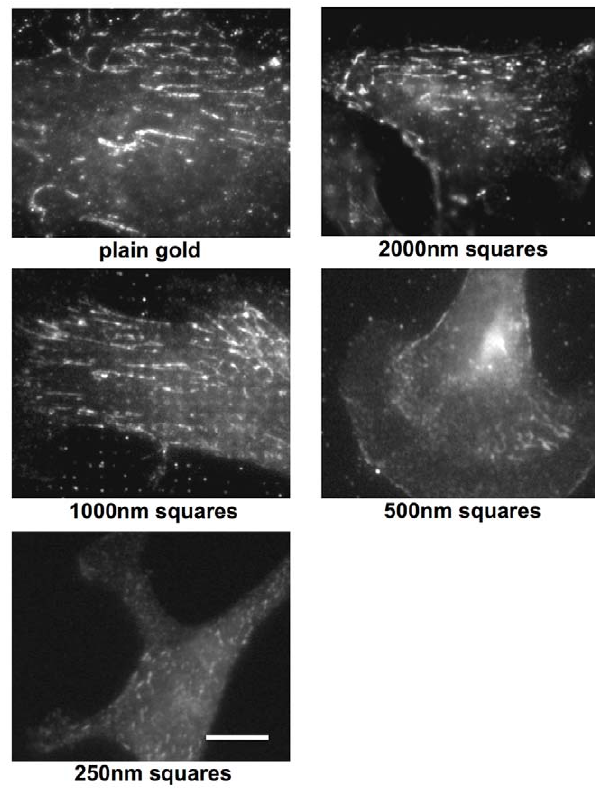
Figure 3. Integrin a 5 b 1 is poorly recruited to matrix adhesions on RGD-gold squares smaller than 1 m m 2 . Cells were grown on RGD-coupled gold patterns for 4 hours with 3% fibronectin free serum and subsequently fixed and stained with an anti- a 5-integrin antibody. Notice that a 5 b 1-integrin localizes to fibrillar adhesions on plain gold and on patterns $ 1 m m 2 , whereas on smaller patterns it is only modestly recruited to cell adhesions. Scale bar is 10 m m.